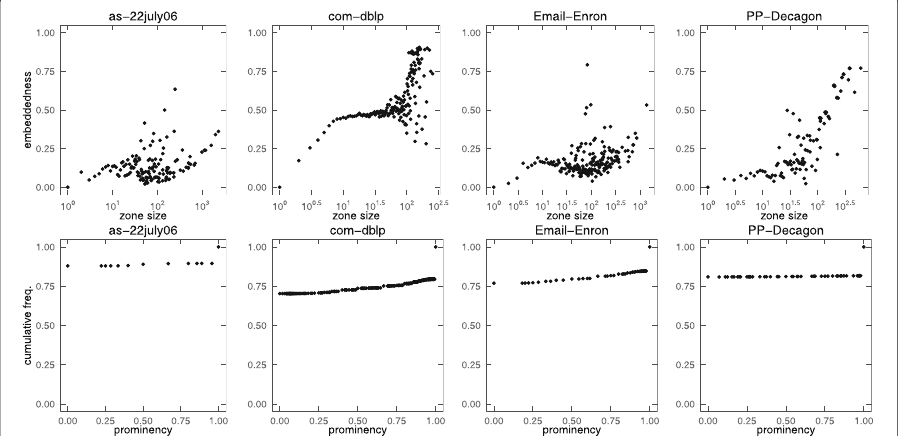
Fig. 12 Embeddedness and prominency in real-world networks. The average embeddedness in relation to the size of the zone is shown in the upper row of plots. Obviously, for all the networks, small zones have a low embeddedness. This is because small zones are often sub-zones of larger zones, and their connection to the surroundings is stronger than in large zones. The occurrence of nodes with a given prominency is shown in the lower row of cumulative distributions. In as-22july06 and PP-Decagon networks, there are not many weakly-prominent nodes (the cumulative distributions are almost not growing). In particular, the technological network as-22july06 has only a few different prominency values. On the other hand, in com-dblp collaboration network, the occurrence of different prominency values is most varied, and frequencies of individual values are higher. For other real-world networks see Figs. 23 and 24 in Appendix